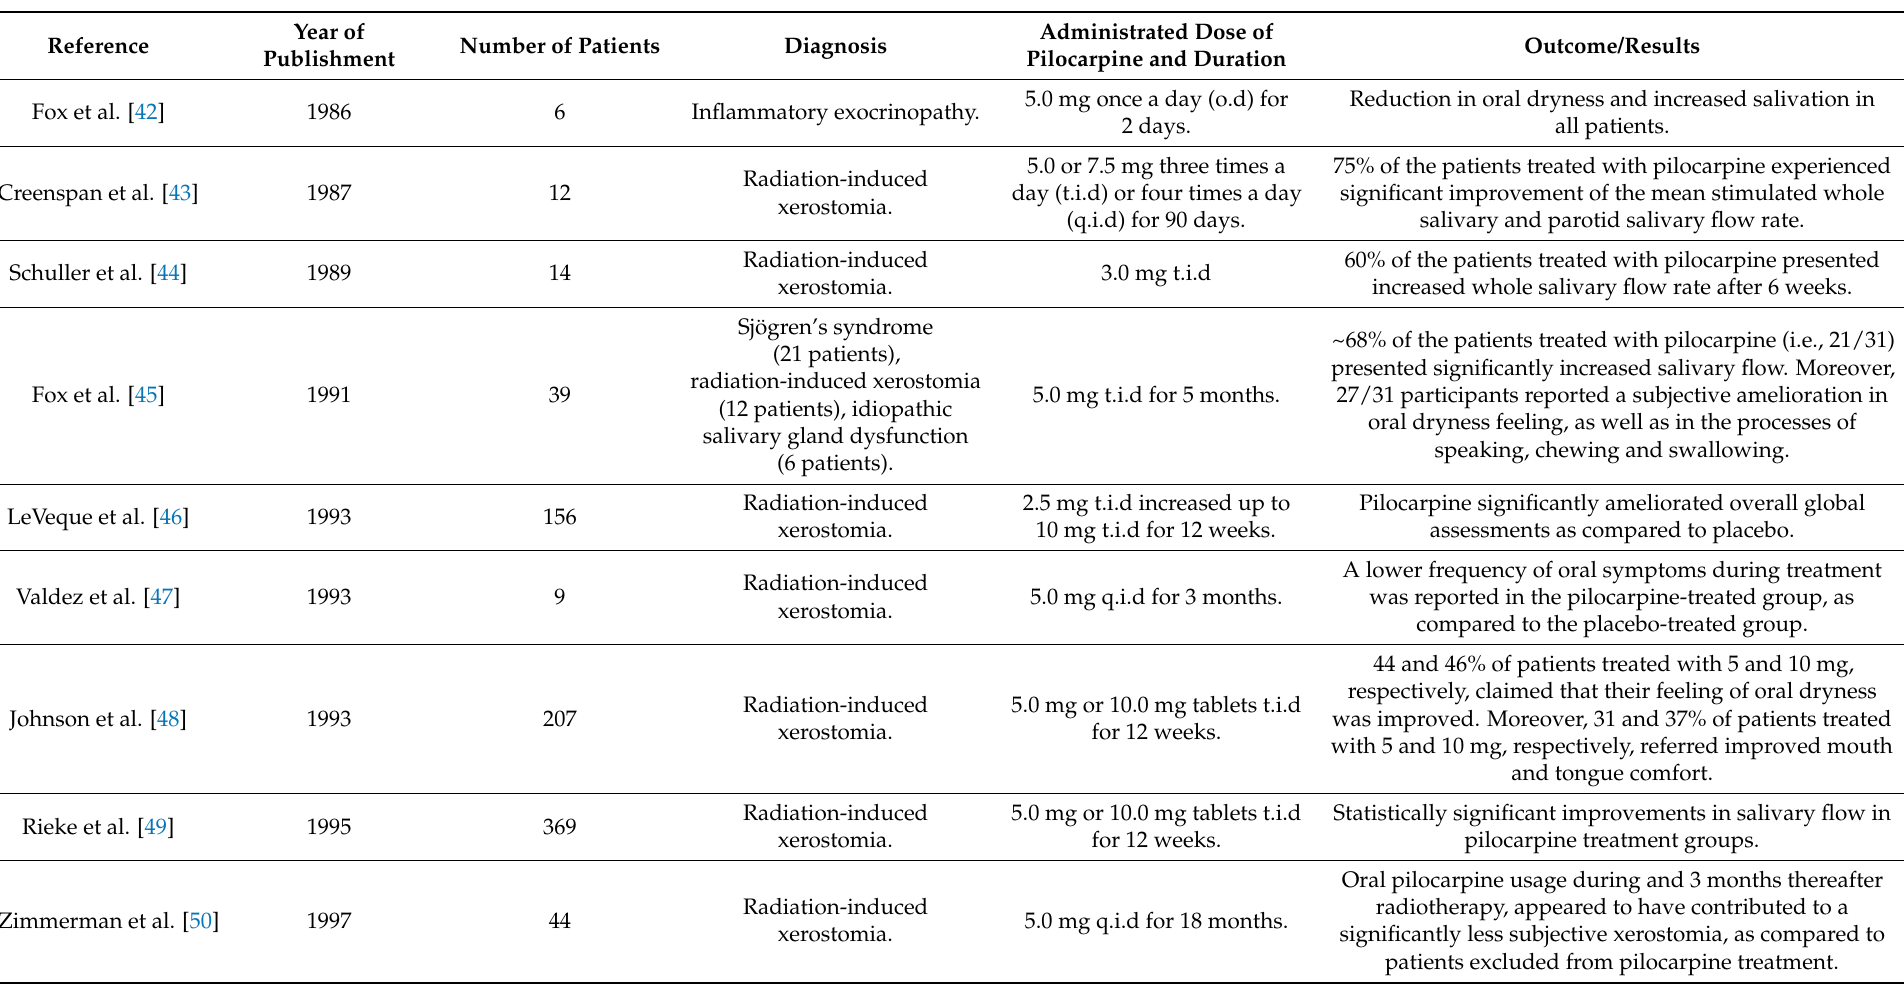
Table 1. Randomized, double-blind, placebo-controlled studies evaluating the clinical efficacy of oral pilocarpine in improving salivary gland flow and relieving symptoms of xerostomia caused by either radiation therapy of the head and neck or salivary gland